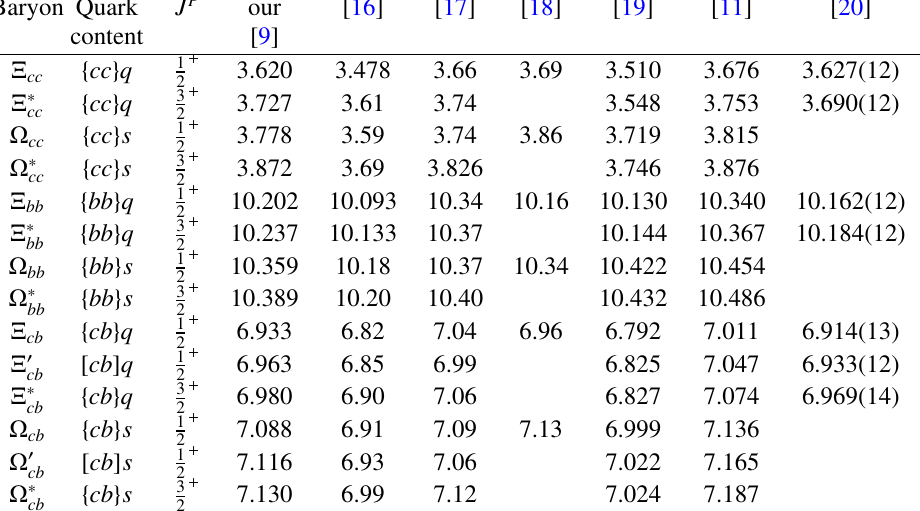
Table 8. Mass spectrum of ground states of doubly heavy baryons (in GeV). { QQ } denotes the diquark in the axial vector state and [ QQ ] denotes diquark in the scalar